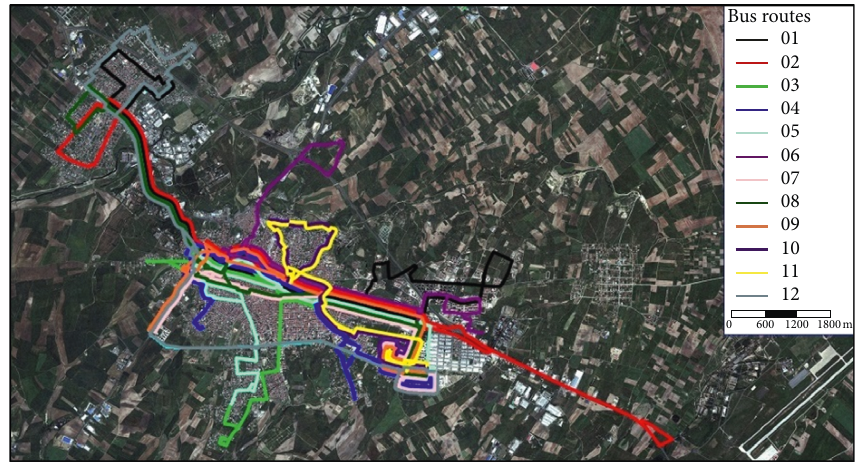
Figure 4: Layout of the studied bus network. Table 1: Lengths and vehicle capacities of bus